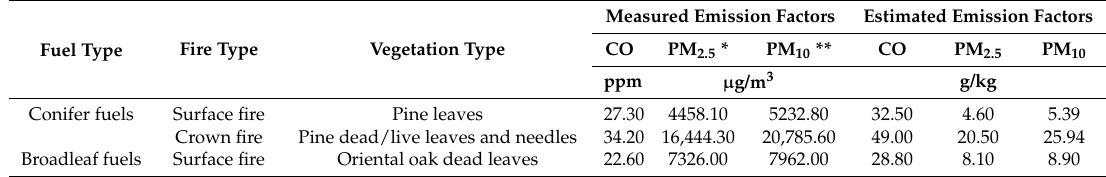
Table 2. Emission factors for smoke pollutants of CO, PM 2.5 , and PM 10